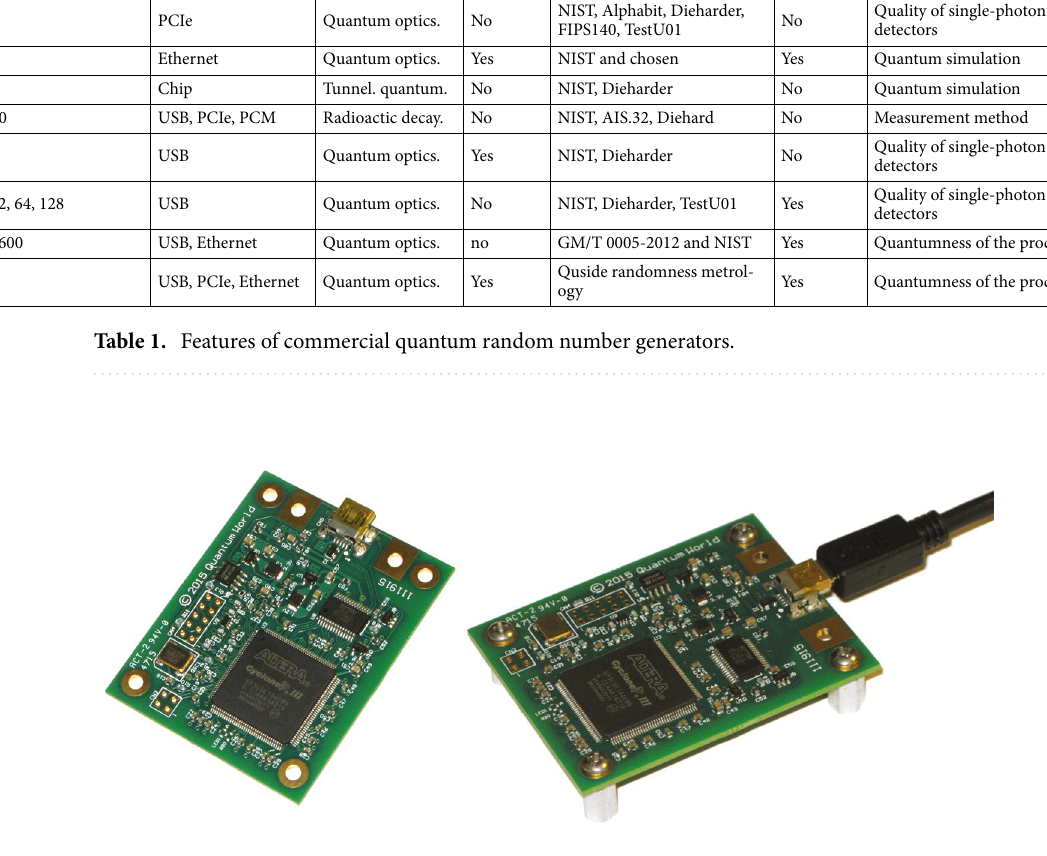
Figure 2. PQ4000KSI quantum random number generator after removing the cover. Generator performance 4Mb/s of random binary